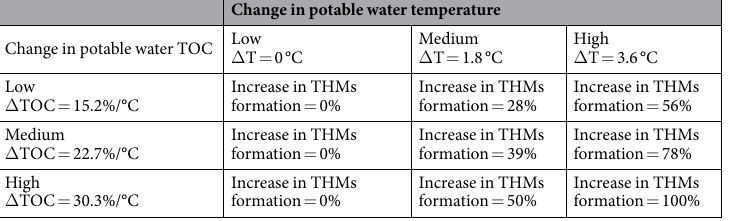
Table 2. Climate change scenarios and their implications for summer THMs formation by